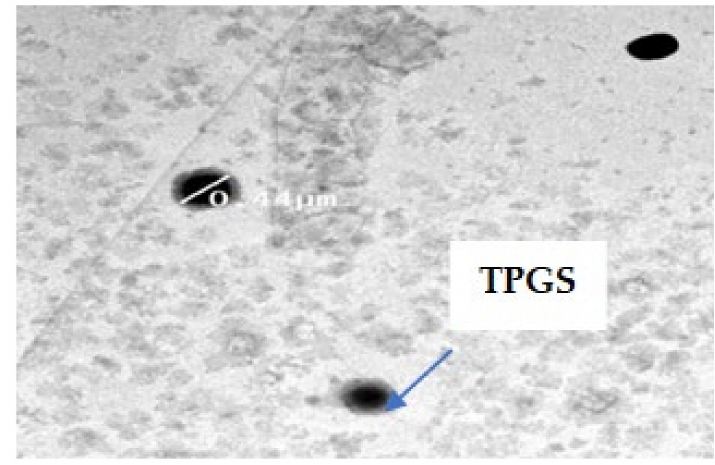
Figure 19. TEM of the elected optimized TPGS-coated niosome.